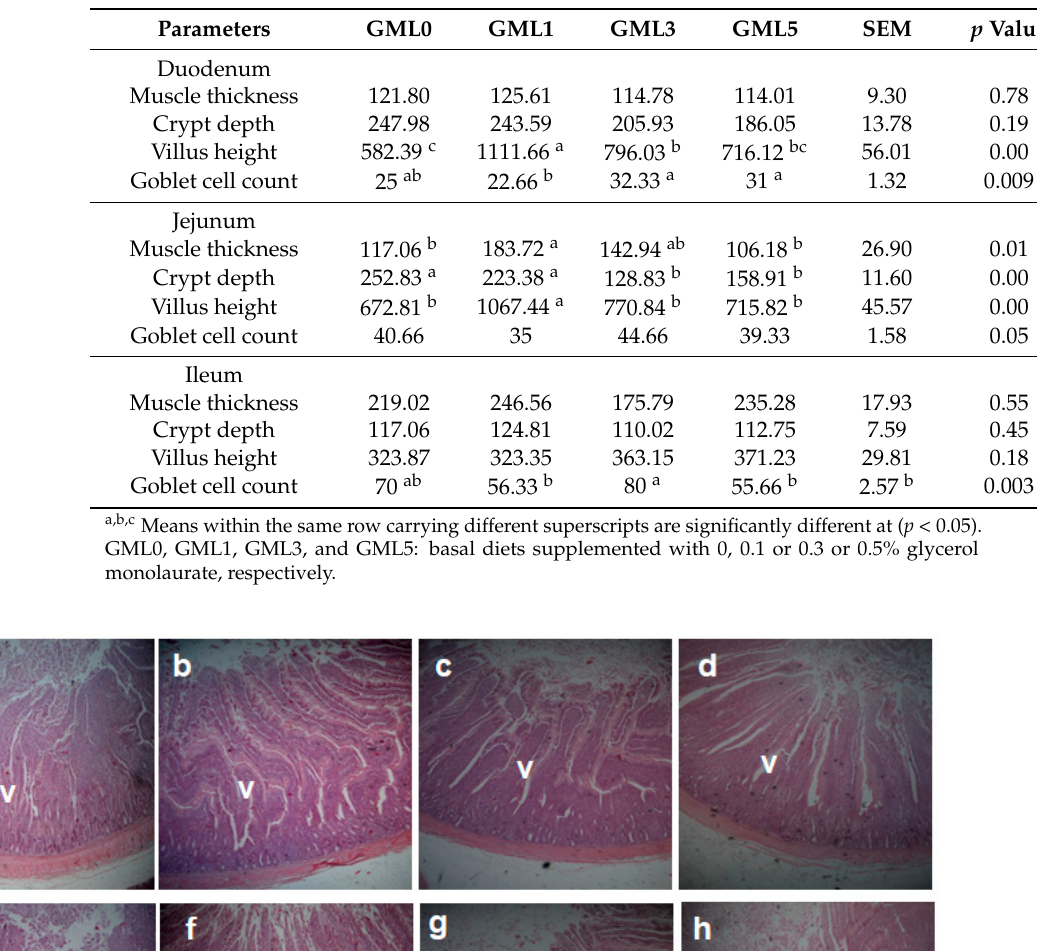
Table 4. The effect of glycerol monolaurate supplementation on the morphometric measures ( µ m) of